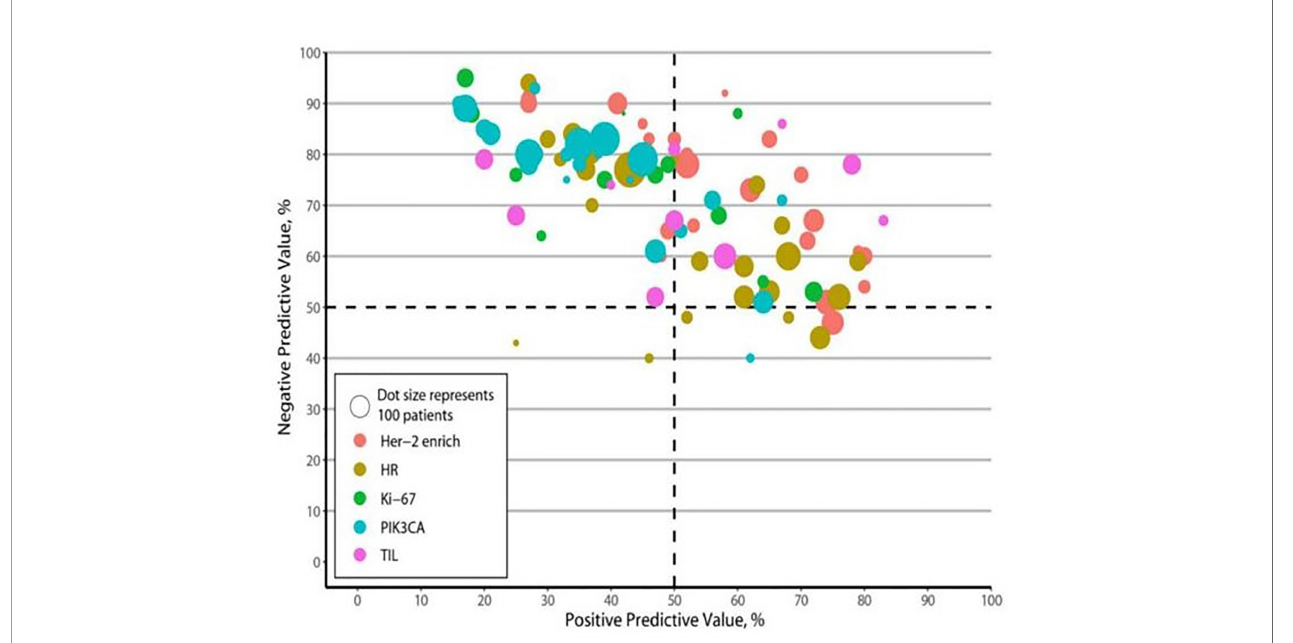
FIGURE 4 | Positive and negative predictive values. HR, hormone receptors; PIK3CA, phosphoinositide 3-kinases; TIL, tumor-in fi ltrating